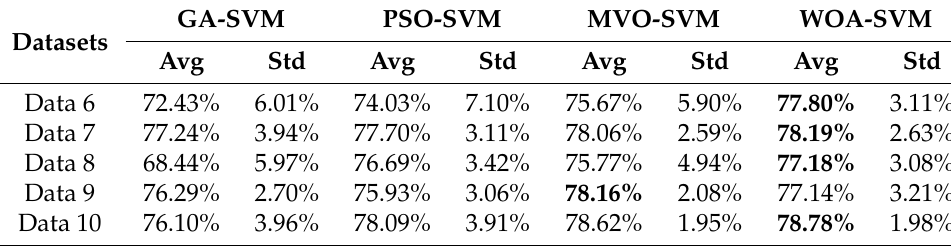
Table 9. Accuracy results of GA-SVM, PSO-SVM, WOA-SVM, and MVO-SVM for Latter-rules datasets.